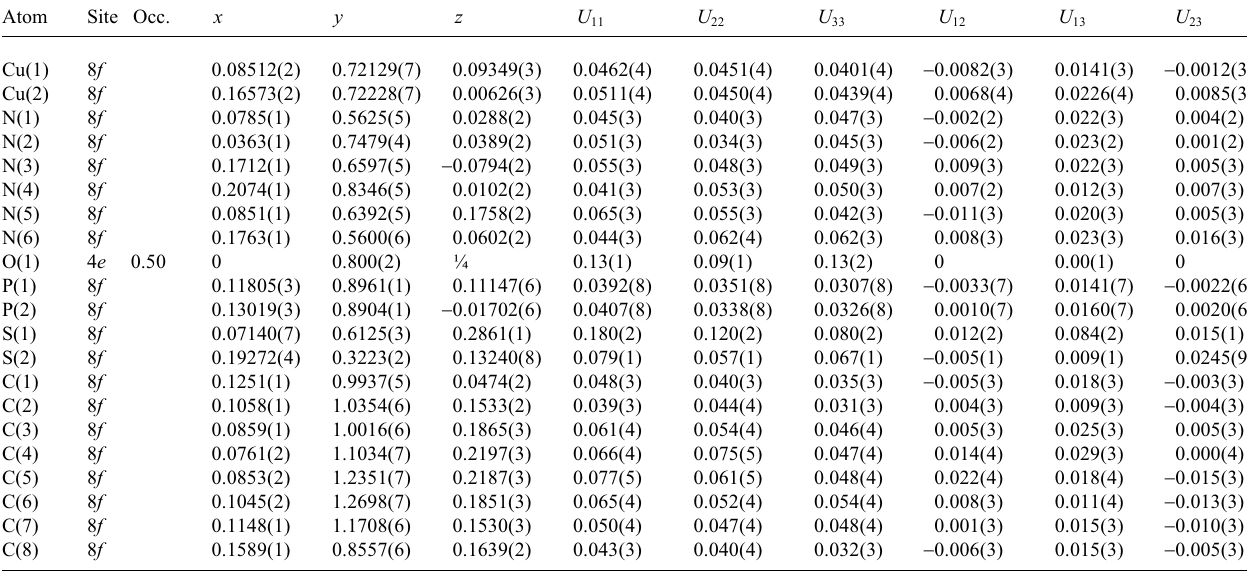
Table 3. Atomic coordinates and displacement parameters (in Å 2 ).